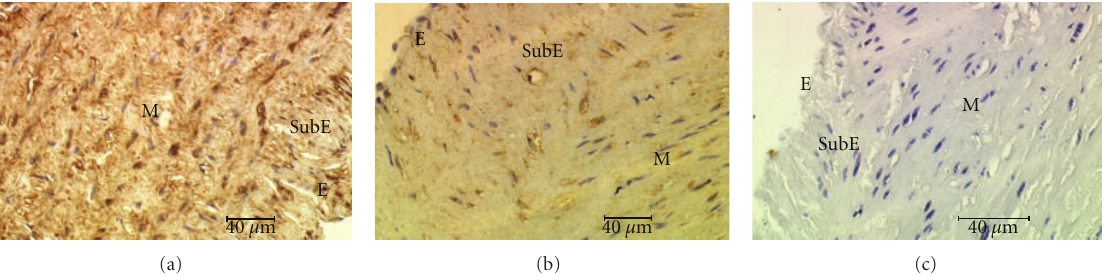
Figure 4: Expression of the Bax in the endothelium (E), subendothelial layer (SubE), and media (M). Group II (a) and Group III (b). (c) represents negative control (Group III).